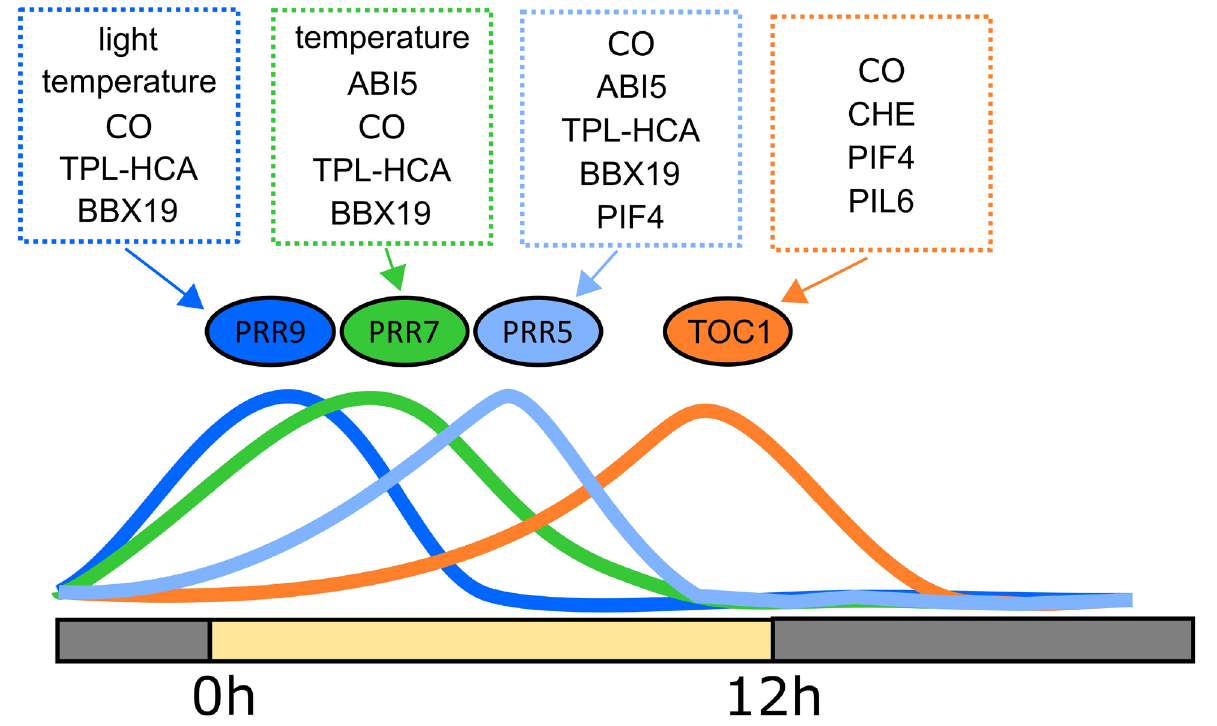
Figure 5 – Regulators of the PRR proteins in Arabidopsis thaliana . AtPRR9 (dark blue), AtPRR7 (green), AtPRR5 (light blue) and AtTOC1 (orange) are expressed during the daytime, forming waves of expression. The PRR proteins make protein-protein complexes that regulate their DNA binding